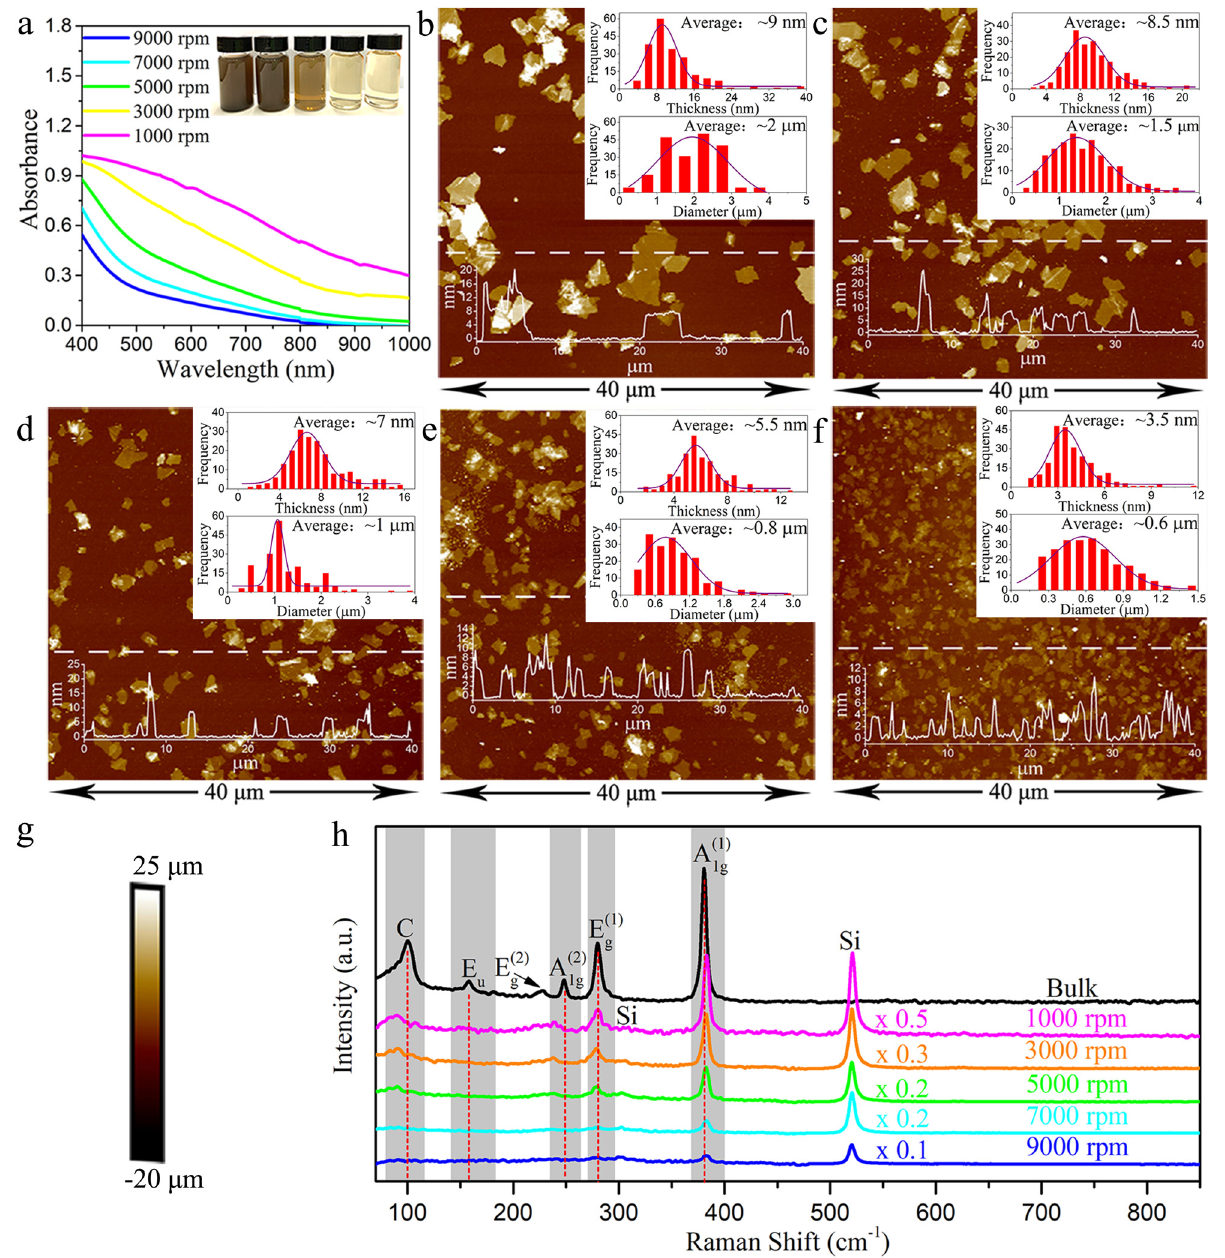
Figure 2: (a) UV – vis absorbance spectra of iron phosphorus trichalcogenide (FePS 3 ) nanosheet dispersions from different centrifugation speedswiththecorrespondingpicturesintheinset.Atomicforcemicroscopy(AFM)imagesofFePS 3 nanosheetswithcorrespondingthickness and lateral size distributions from different centrifugation speeds of (b) 1000, (c) 3000, (d) 5000, (e) 7000 and (f) 9000 rpm with (g) the thickness step scale bar of − 20 to 25 μ m. (h) Raman spectra of bulk FePS 3 crystals (black) and FePS 3 nanosheets obtained from different centrifugation speedsof 1000rpm (magenta), 3000rpm (orange),5000rpm(green),7000rpm(cyan)and9000 rpm(blue).It shouldbe noted that all samples with different Raman intensities were characterized under the same conditions on a SiO 2 /Si substrate at a laser excitation wavelength of 532 nm. The spectral features at approximately 527 and 300 cm − 1 represent the fi rst-order and second-order Raman peak of silicon,